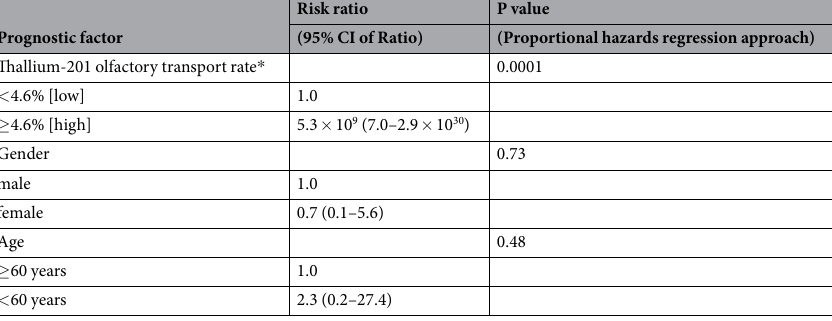
Table 2. Multivariable analysis of prognostic factors. * Data dichotomized at the optimal cutoff